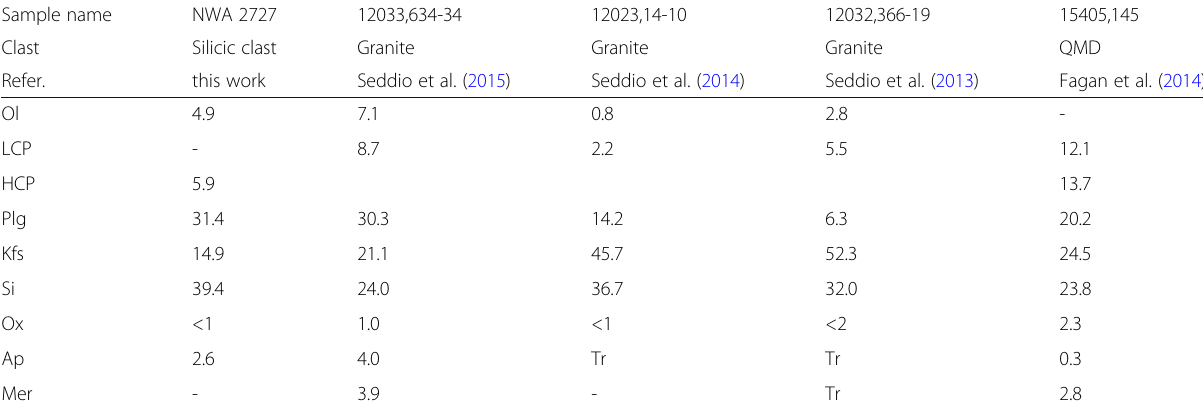
Table 1 Modal abundances (vol%) of minerals in the NWA 2727 silicic clast, Apollo granite, QMD